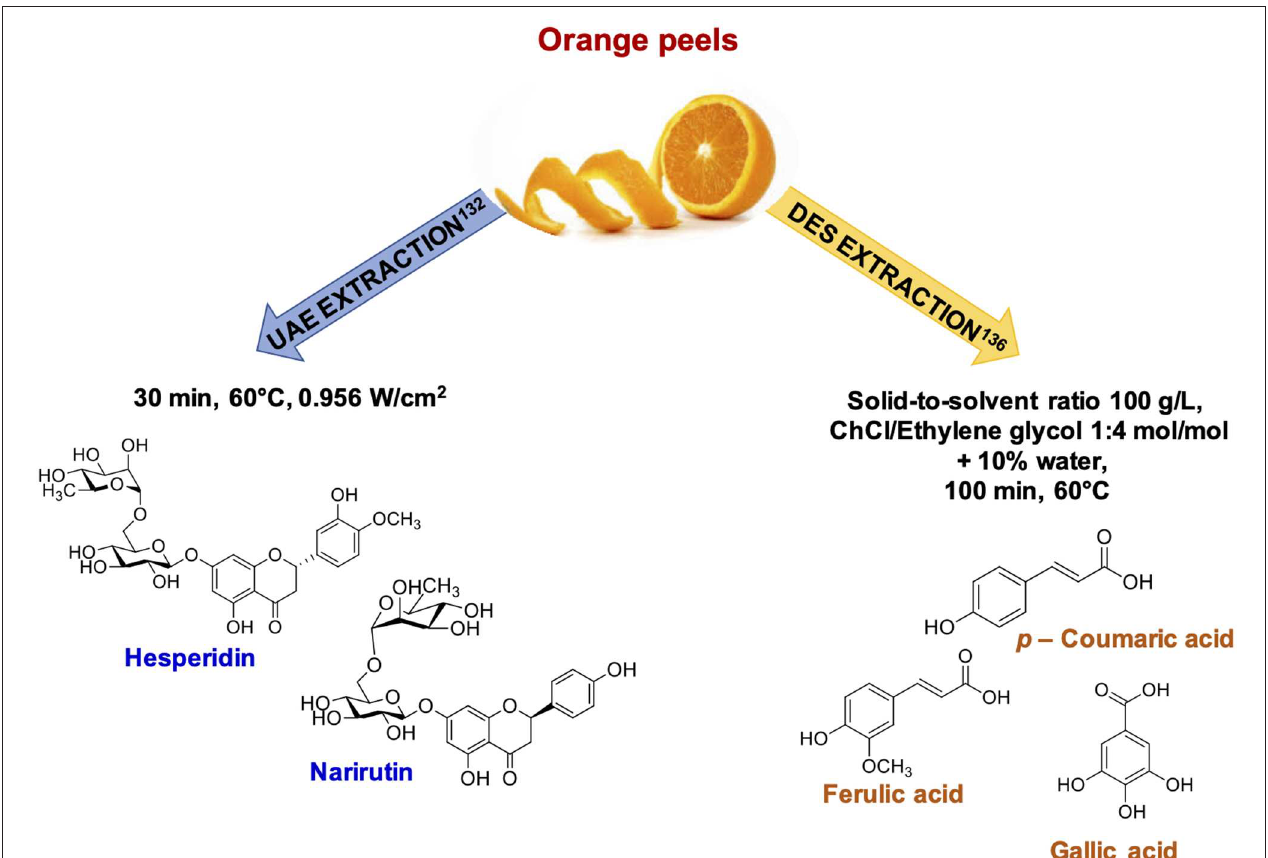
FIGURE 9 | Representative examples of phenolic compounds recovered from orange byproducts.